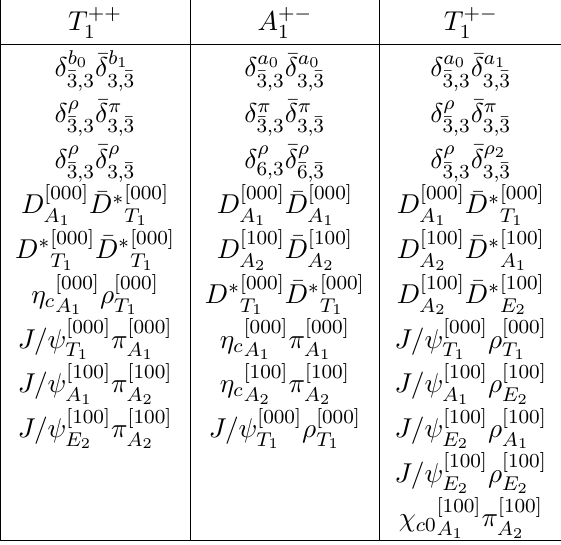
(cid:22) (cid:14) (cid:0) 2 where R 1 ( R 2 ) is the colour R 1 ;F 1 R 2 ;F 2